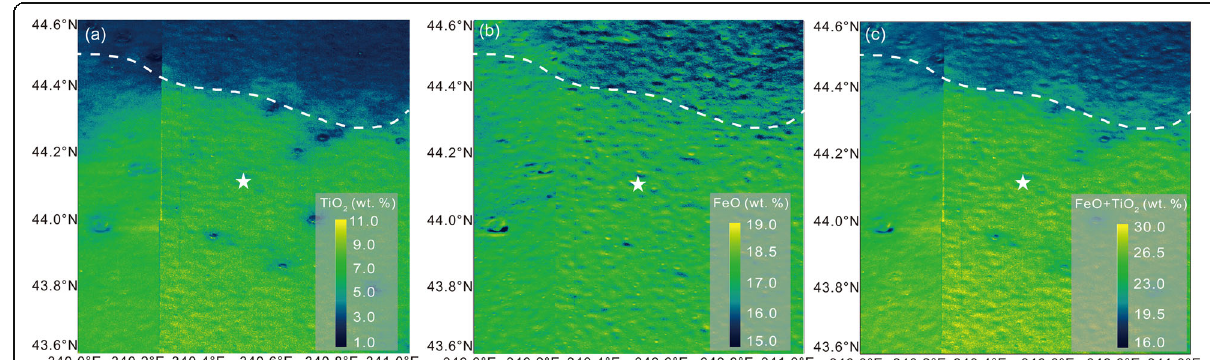
Fig. 6 The TiO 2 ( a ), FeO ( b ), and their combined ( c ) contents at the CE-3 landing site (white stars). The data are derived from the Multispectral Imager data, and the maps are revised from Zhao et al. (2014). The white dashed line is the boundary between the Imbrian- (north) and Eratosthenian-aged mare units (down). North is up in all the